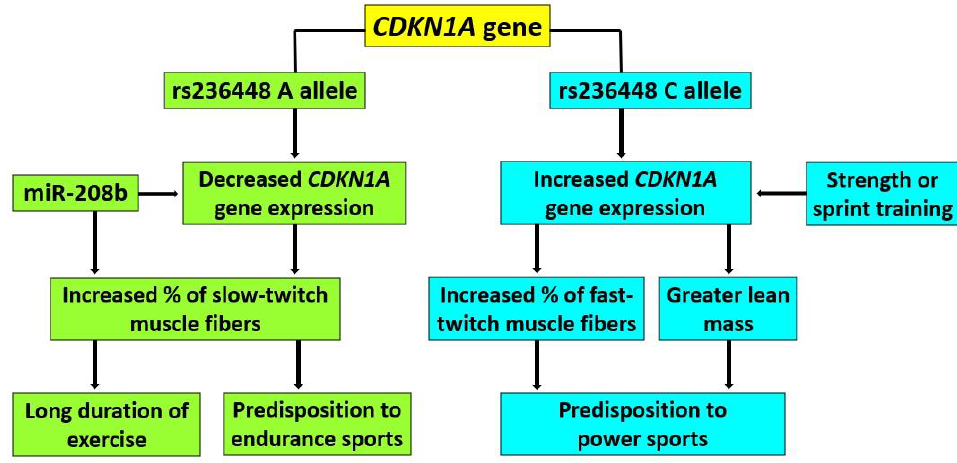
Figure 4. Scheme showing the hypothesized mechanism for the association of rs236448 alleles and various factors with muscle fiber composition and exercise-related phenotypes.